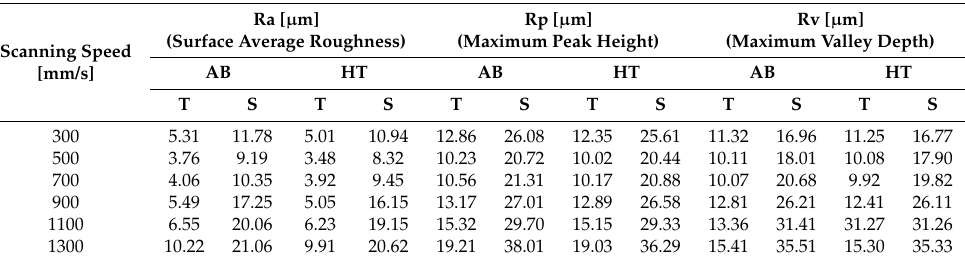
Table 3. Roughness